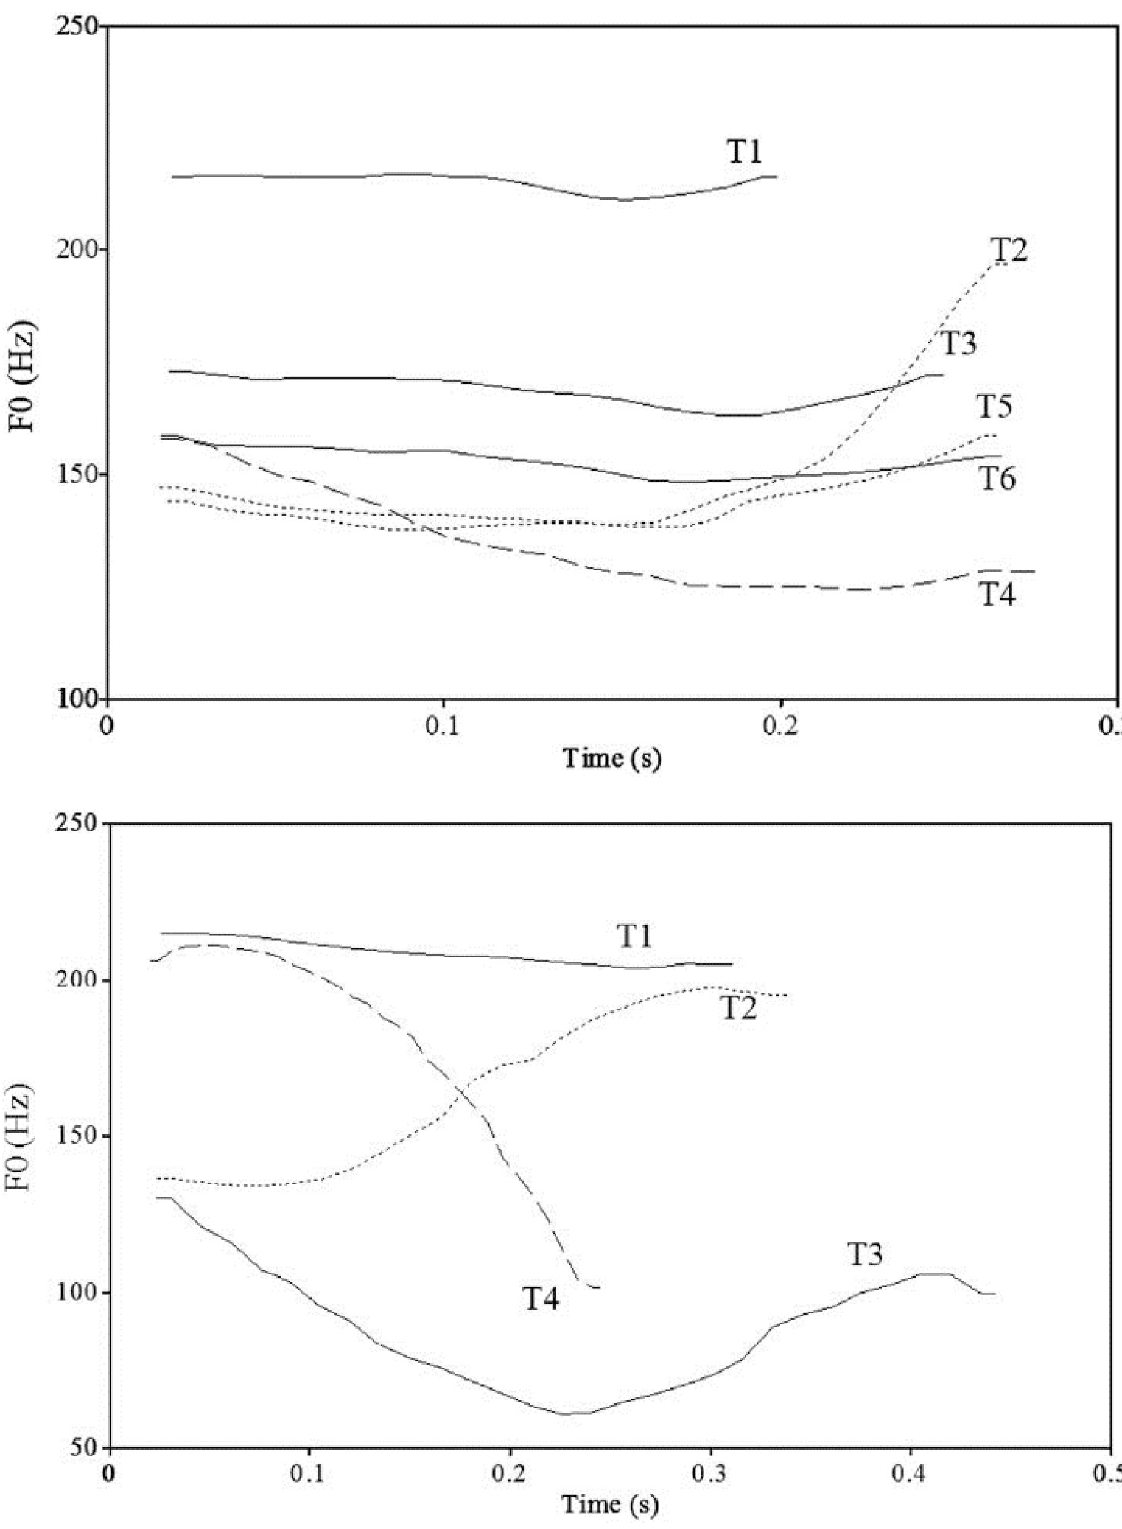
Fig 1. Tone contours of the six Cantonese tones and four Mandarin tones. The Cantonese tones (top panel) were produced by a female native speaker of Hong Kong Cantonese. The Mandarin tones (bottom panel) were produced by a male native speaker of Beijing Mandarin. Both figures were adopted from Qin & Jongman, 2016 for the purpose of